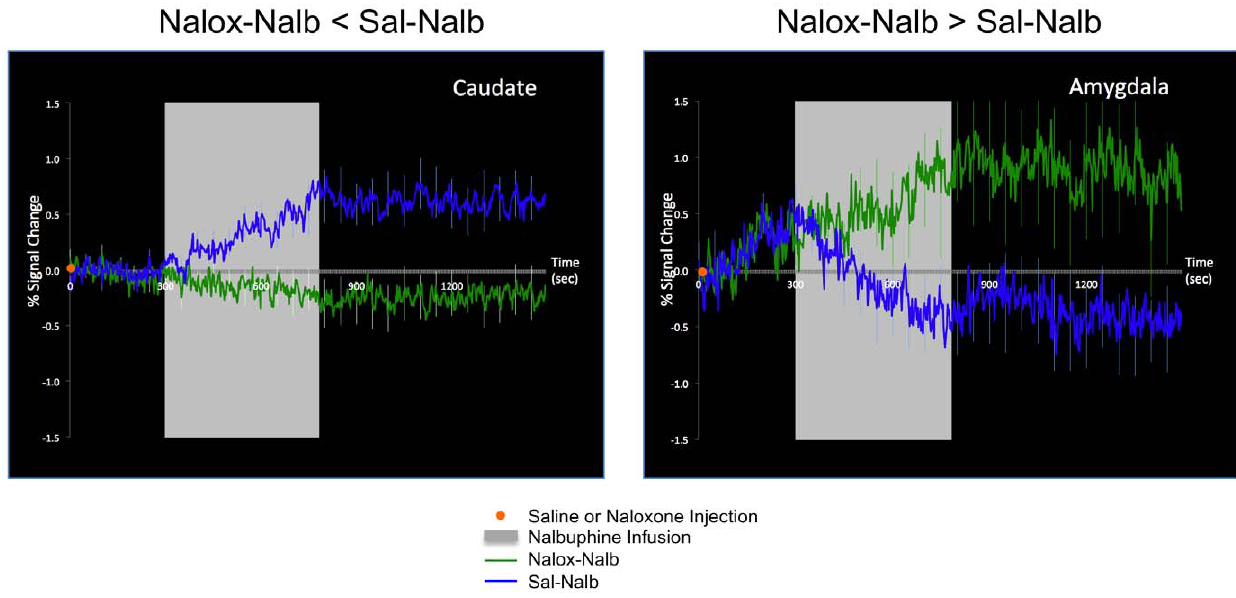
Figure 2. Examples of infusion-initiated BOLD signal changes. Shown is an example in which the Nalb-Sal treatment induced greater activation (i.e., caudate), and an example in which the Nalb-Nalox treatment induced greater activation (i.e., amygdala).